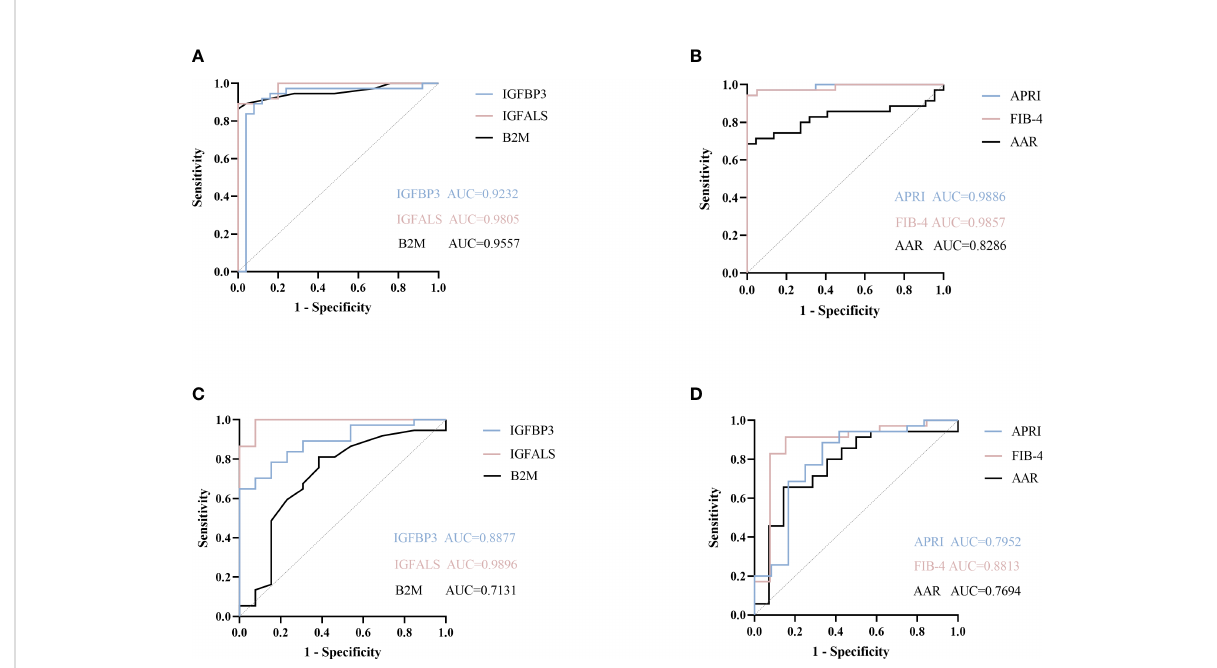
FIGURE 3 ROC curve of potential proteins. (A) ROC curve of B2M, IGFBP3, and IGFALS to diagnose severe ALD from HC group. (B) ROC curve of APRI, FIB-4, AAR to diagnose severe ALD from HC group. (C) ROC curve of B2M, IGFBP3, and IGFALS to diagnose severe ALD from non-severe ALD group. (D) ROC curve of APRI, FIB-4, AAR to diagnose severe ALD from non-severe ALD